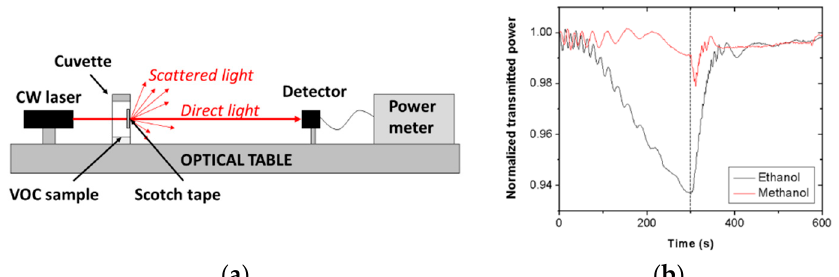
Figure 8. ( a ) Schematic diagram of the setup used for optical interrogation of a Scotch tape vapor sensor. ( b ) Normalized transmitted optical power at 635 nm wavelength through a piece of Scotch tape subjected to ethanol (black line) and methanol (red line) vapor exposure–exhaust measurements. Reproduced from [110].